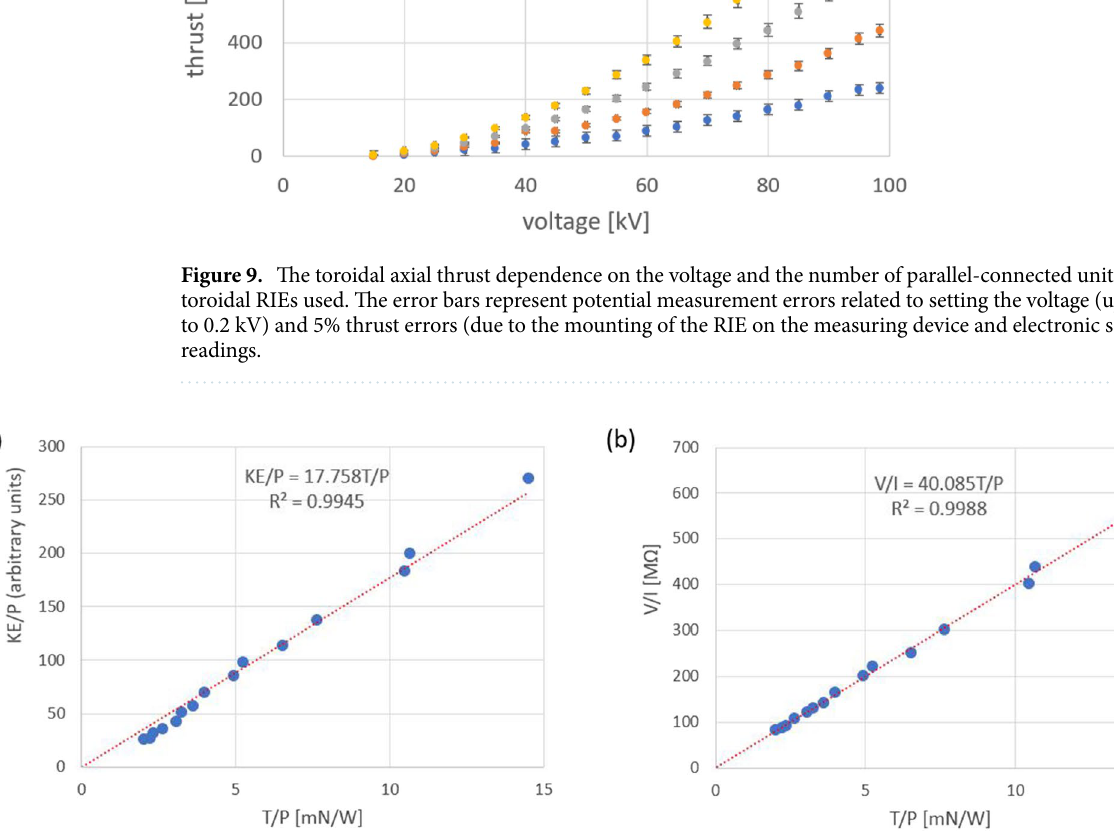
Figure 10. ( a ) Experimentally observed direct proportionality of the thrust to power ratio (T/P) and the propeller kinetic energy to power ratio (KE/P). ( b ) Experimentally observed direct proportionality of the T/P ratio and the voltage to current (V/I)